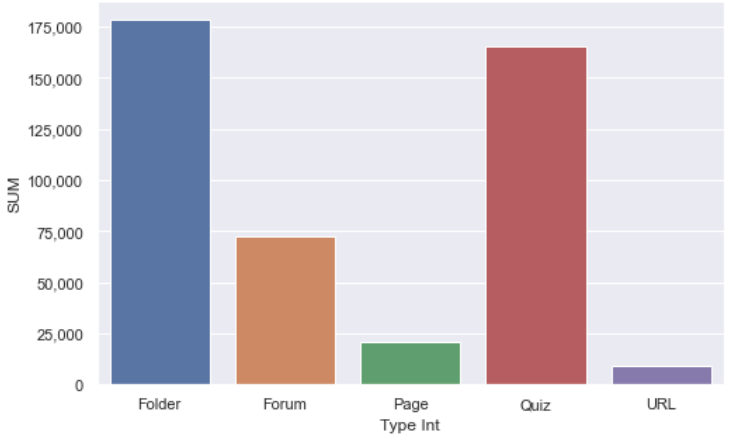
Figure 9. Type of